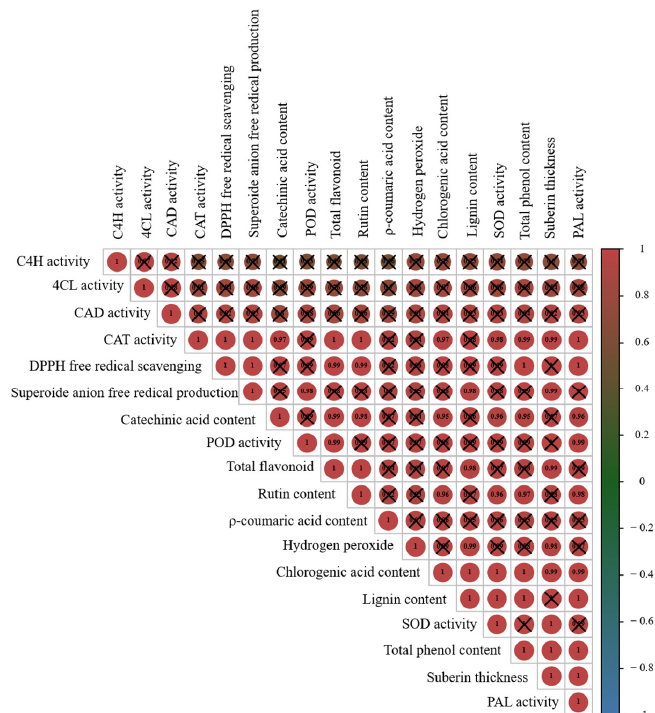
Figure 6. Correlation analysis of substances affecting sweet potato callus under different RHT treatments. Red: positive correlation. Blue: negative correlation. Numbers: significance of correlation. X: p > 0.01.